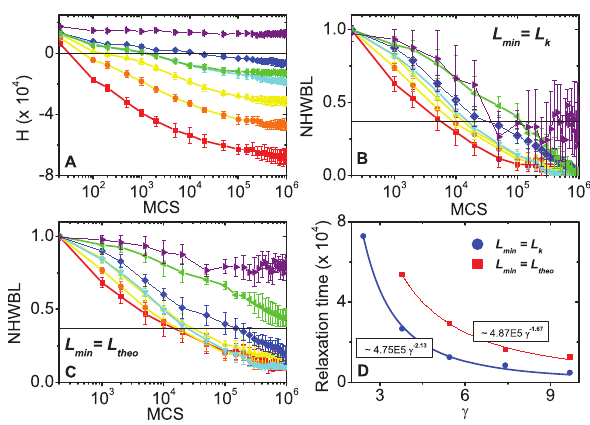
Figure 4. Evolution of the effective energies (H) and normal- ized weighted heterotypic boundary lengths (NWHBL) for N aggregates expressing 2 cadherins levels modeled with the – [1, 20.25]; m – [1, 17.50]; . – THBM. Expression ranges: & – [1, 23]; [1,14.75]; b – [12, 23]; % – [1, 12]; c – [19.62, 23]. Black solid horizontal lines mark 1/e. ( A ) Evolution of H . ( B ) – ( C ) Evolution of NWHBL for the